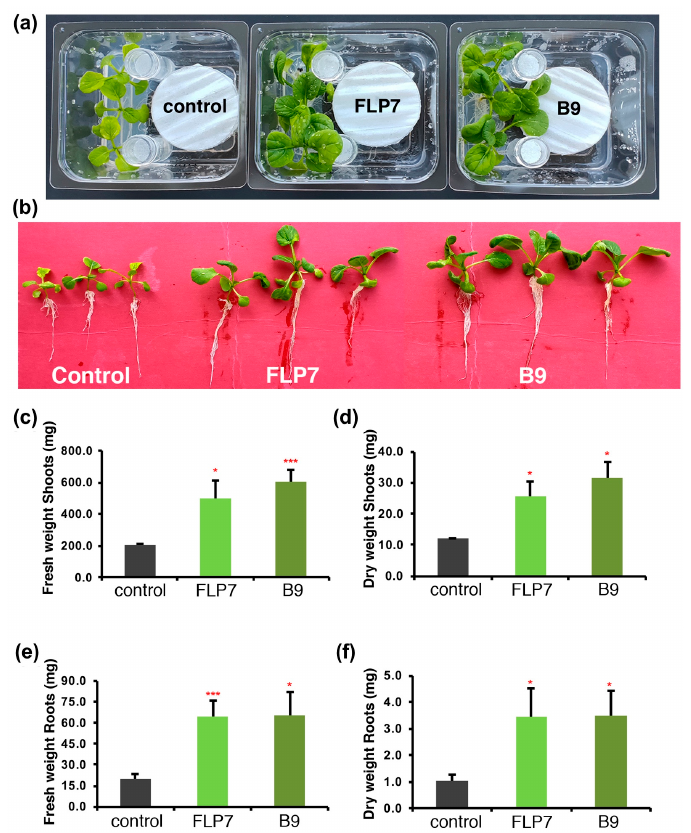
Figure 3. Volatile organic compounds from P. citrinum isolates stimulate robust seedling growth in Choy Sum. ( a ) The morphological traits of Choy Sum seedlings grown in tripartite Phytatray II for 10 days; ( b ) the seedlings from ( a ); ( c – f ) quantification of the fresh and dry weight of shoots ( c , d ) and roots ( e , f ) from the seedlings incubated individually with P. citrinum B9 or FLP7 conidia. Data represents means ± SDs from 3 replicates each consisting of 8 plants. Barium hydroxide was used to quench excess CO 2 produced by fungal growth and/or metabolism. Control (mock) inoculation utilized the growth medium (PA, prune agar) without any fungus. Differences were deemed significant at a probability level of p < 0.05 (*) or p <